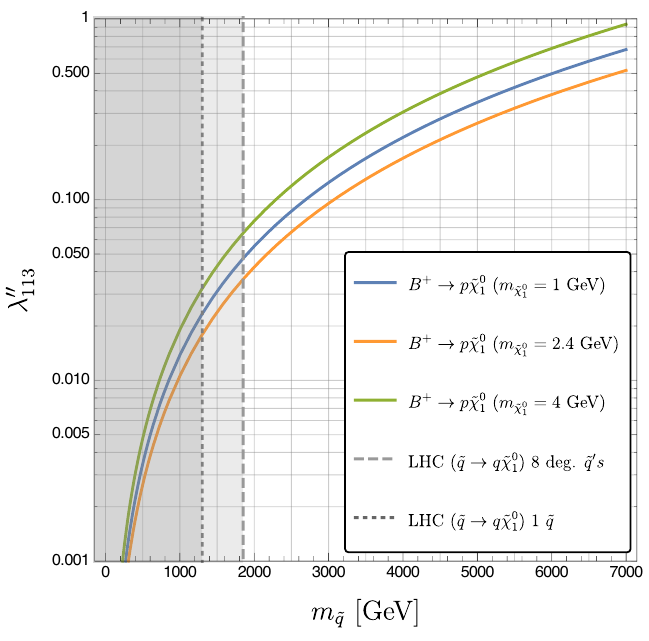
Figure 7 . The expected upper bounds on λ 00 vs. m ˜ q at Belle II for different values of the neutralino 113 mass m , extracted from the proposed search for B + → p ˜ χ 0 assuming the sensitivities given in ˜ χ 0 1 1 section 3.2. We also plot current collider limits on the scalar squark masses under the hypotheses of eight mass-degenerate light-flavor squarks ( m ˜ q & 1850 GeV) and only one light-flavor squark state ( m ˜ q & 1300 GeV)